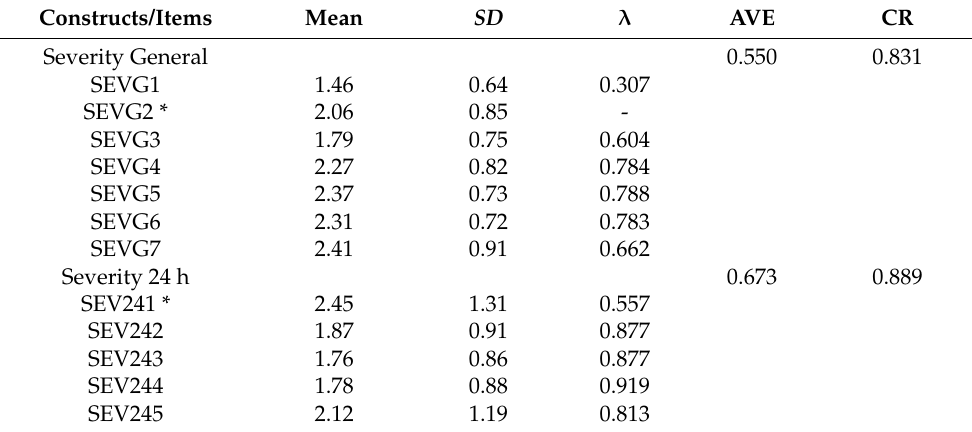
Table 4. Factor loading, convergent reliability, and convergent validity of the confirmatory factor analysis for the severity domain ( n = 323).